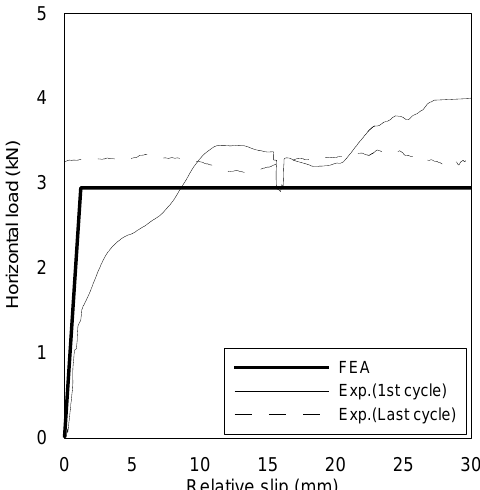
Figure 10. Horizontal load – slip relationships (only +direction, 10 kN vertically loaded).